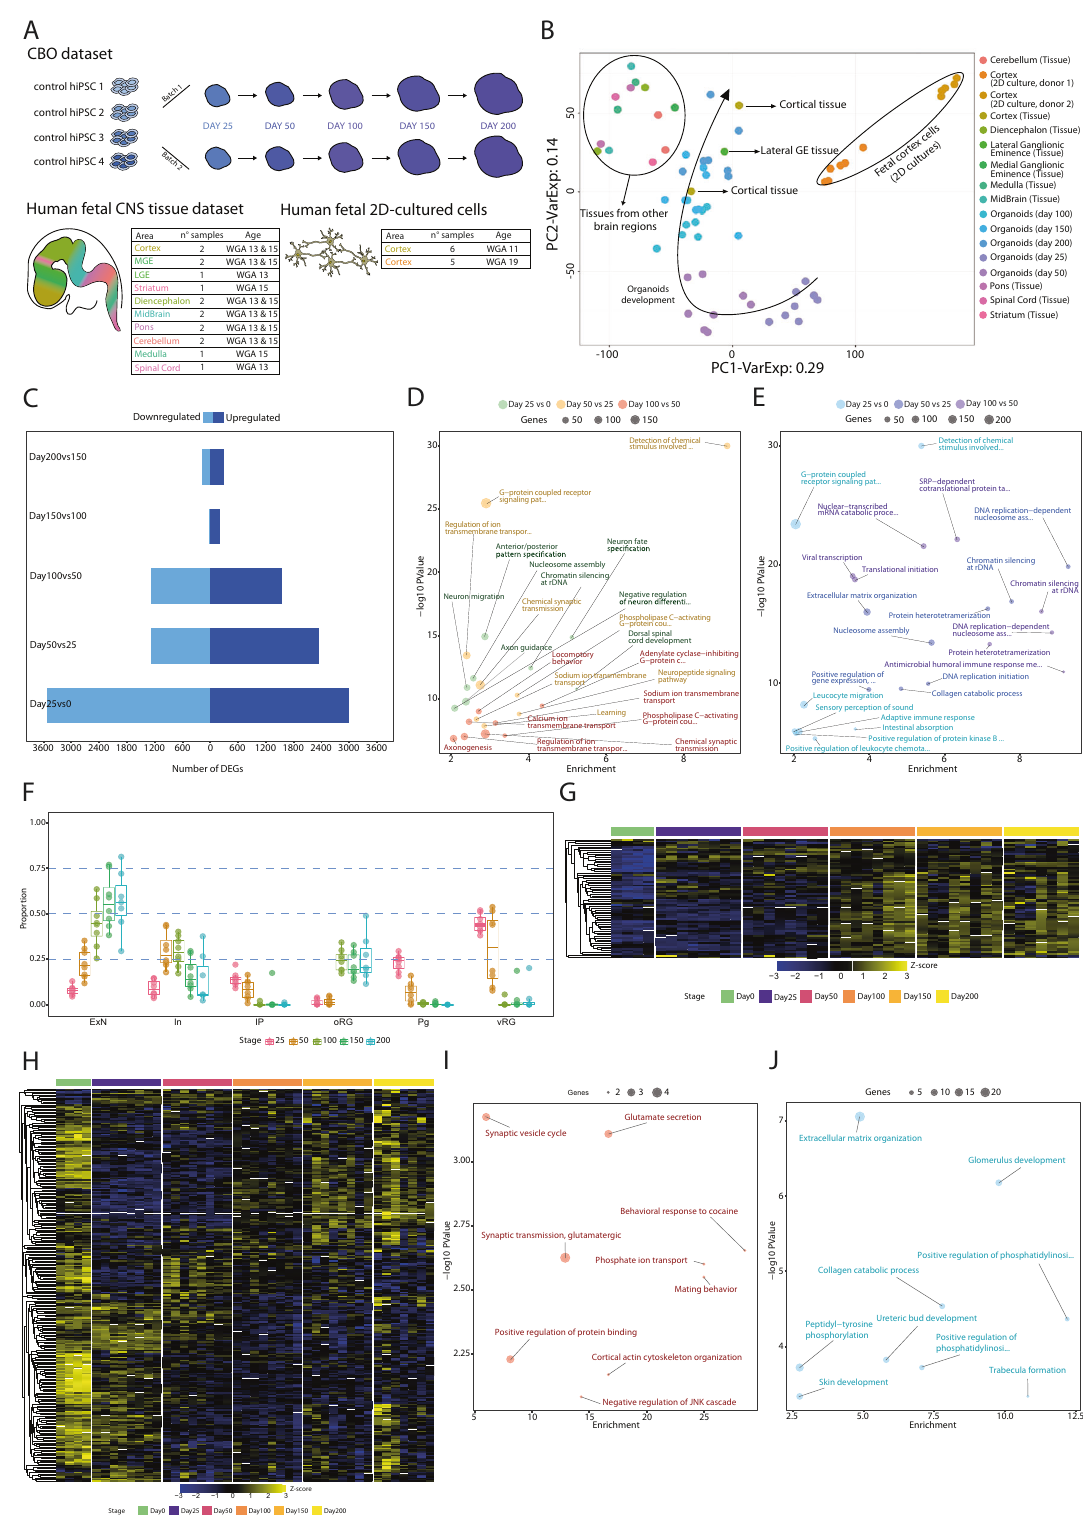
Cortical brain organoids globally resemble the developing human fetal cortex and evolve in two steps Upon characterization of the transcriptional dynamics de fi ning human corticogenesis, we investigated the extent of their recapitulation in BO, with an experimental design that allowed us to measure interindividual and technical variability.